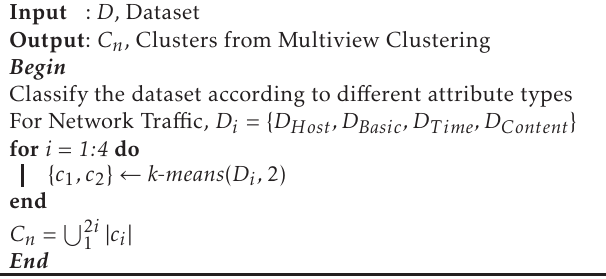
ALGORITHM 2: Multiview Clustering of Network Tra ffi c